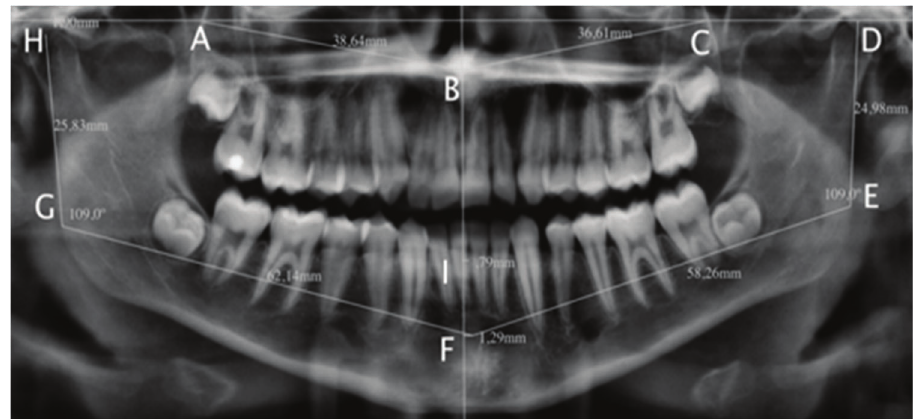
Figure 1 - Maxillomandibular cephalometric assessment. A. posterior side of the right jaw; B. anterior nasal spine; C. posterior side of the left maxilla; D. head of the left jaw; E . left mandibular angle; F. mentonian fossa; G. right mandibular angle; H. right jaw head; I. apex of the inferior interincisal alveolar